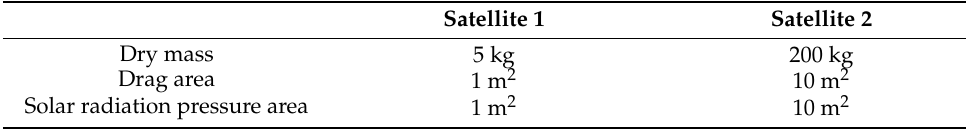
Table 10. Satellites with different mass and drag area characteristics for additional performed simulations.